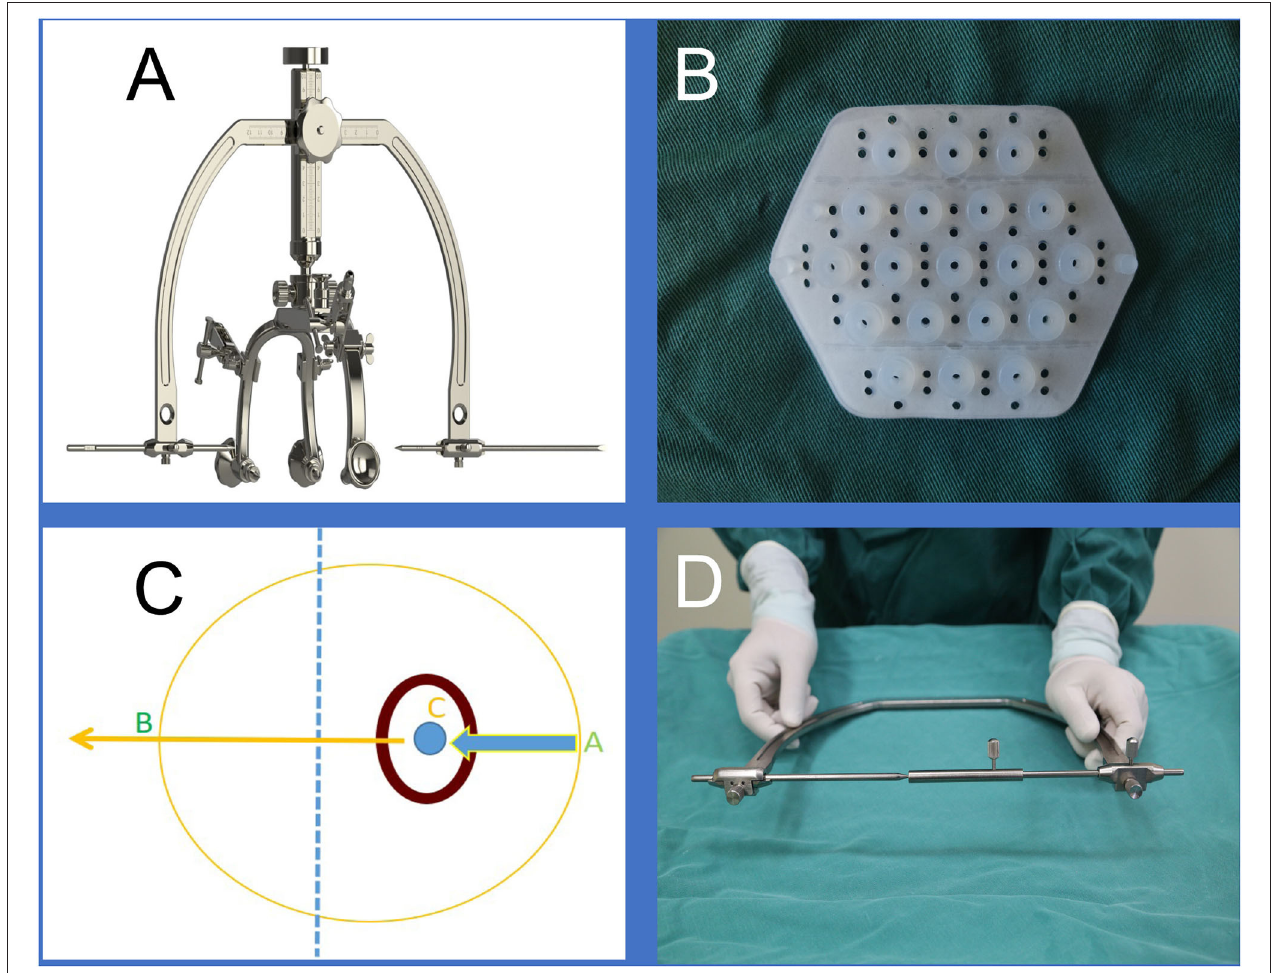
FIGURE 1 | (A) is the brain surgery head frame, (B) is the location sticker, (C and D) shows that our design was based on the theory of “three points on one line,” where the three points are the scalp puncture site, the hematoma center site, and the reference point, and the one line refers to the straight line formed by the three